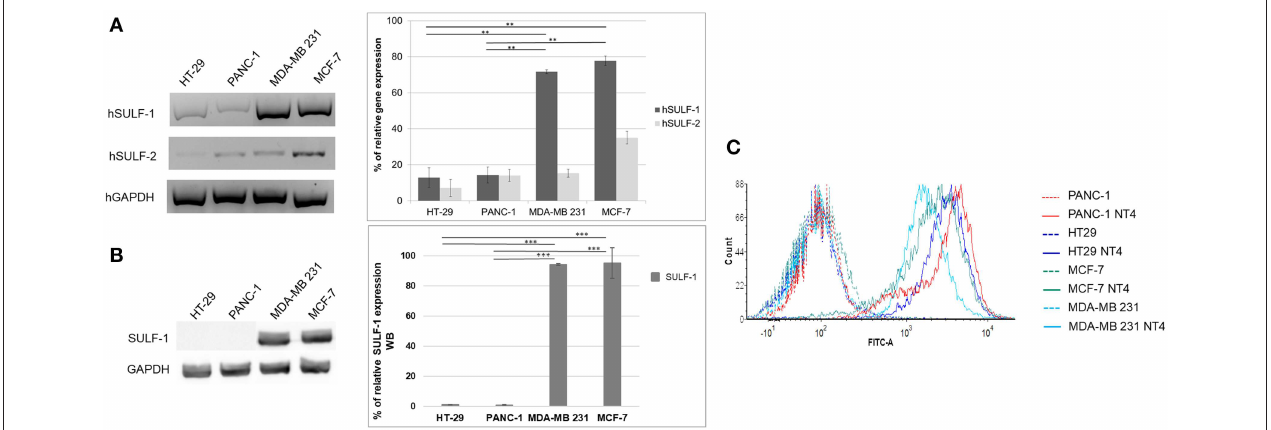
FIGURE 3 | (A) Gene expression of hSULF-1 and hSULF-2 in HT-29, PANC-1, MCF-7, and MDA-MB-231 cell lines analyzed by RT-PCR. The GAPDH gene was tested as endogenous control. Histograms represent percentage of gene expression compared to GAPDH (GAPDH is 100%). (B) SULF-1 expression analyzed by Western blot in the same cell lines. Histograms represent percentage of SULF-1 expression compared to GAPDH (GAPDH is 100%). Significance of the differences was calculated using Student’s t -test and GraphPad, ** p < 0.01; *** p < 0.001. (C) NT4 binding analyzed by flow cytometry in HT-29, PANC-1, MCF-7, and